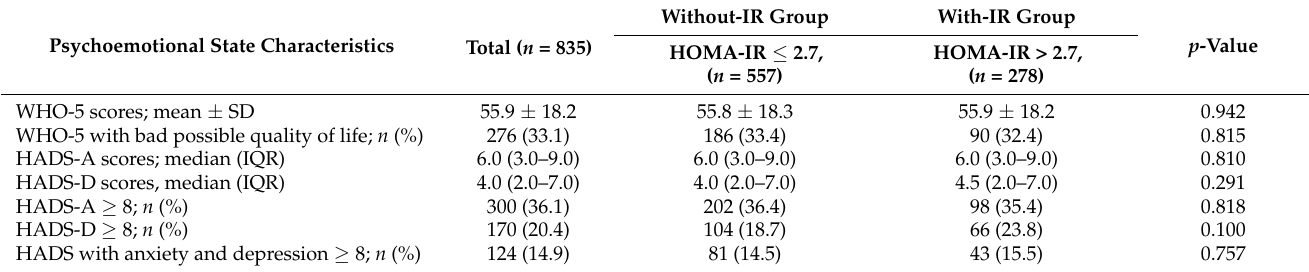
Table 2. The psychoemotional state characteristics of subject groups without and with insulin resistance (IR).